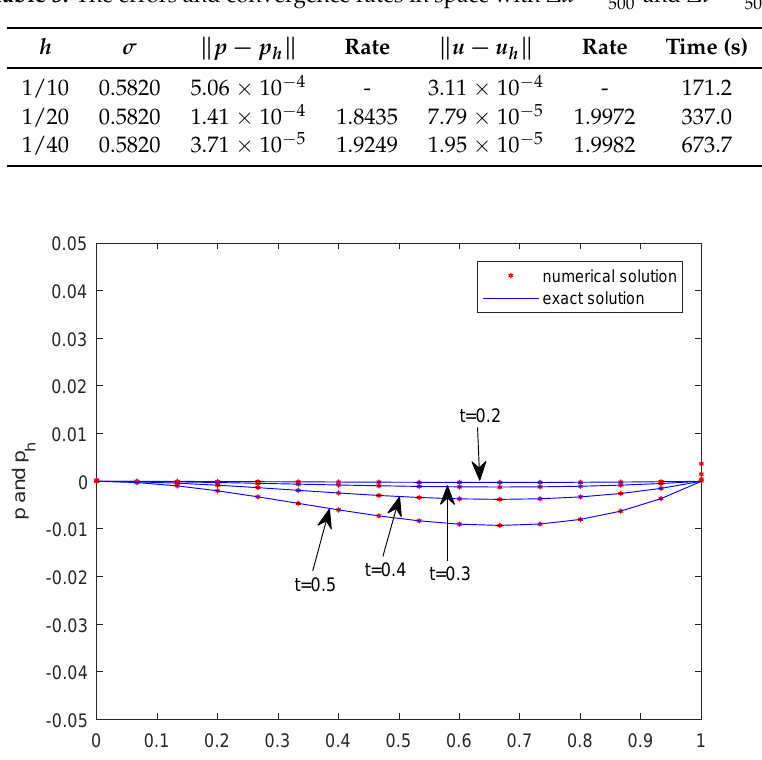
Table 3. The errors and convergence rates in space with ∆ α = 1